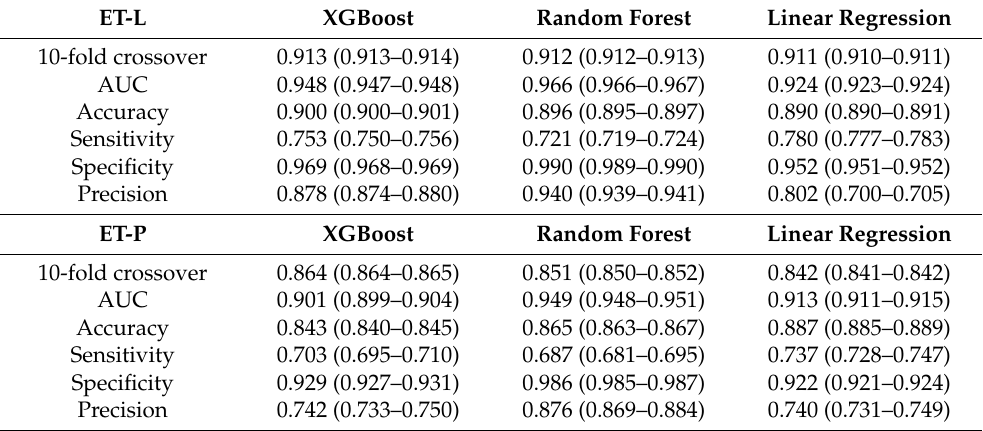
Table 2. Accuracy, sensitivity, specificity, and precision in the prediction model generated with a machine learning approach, according to